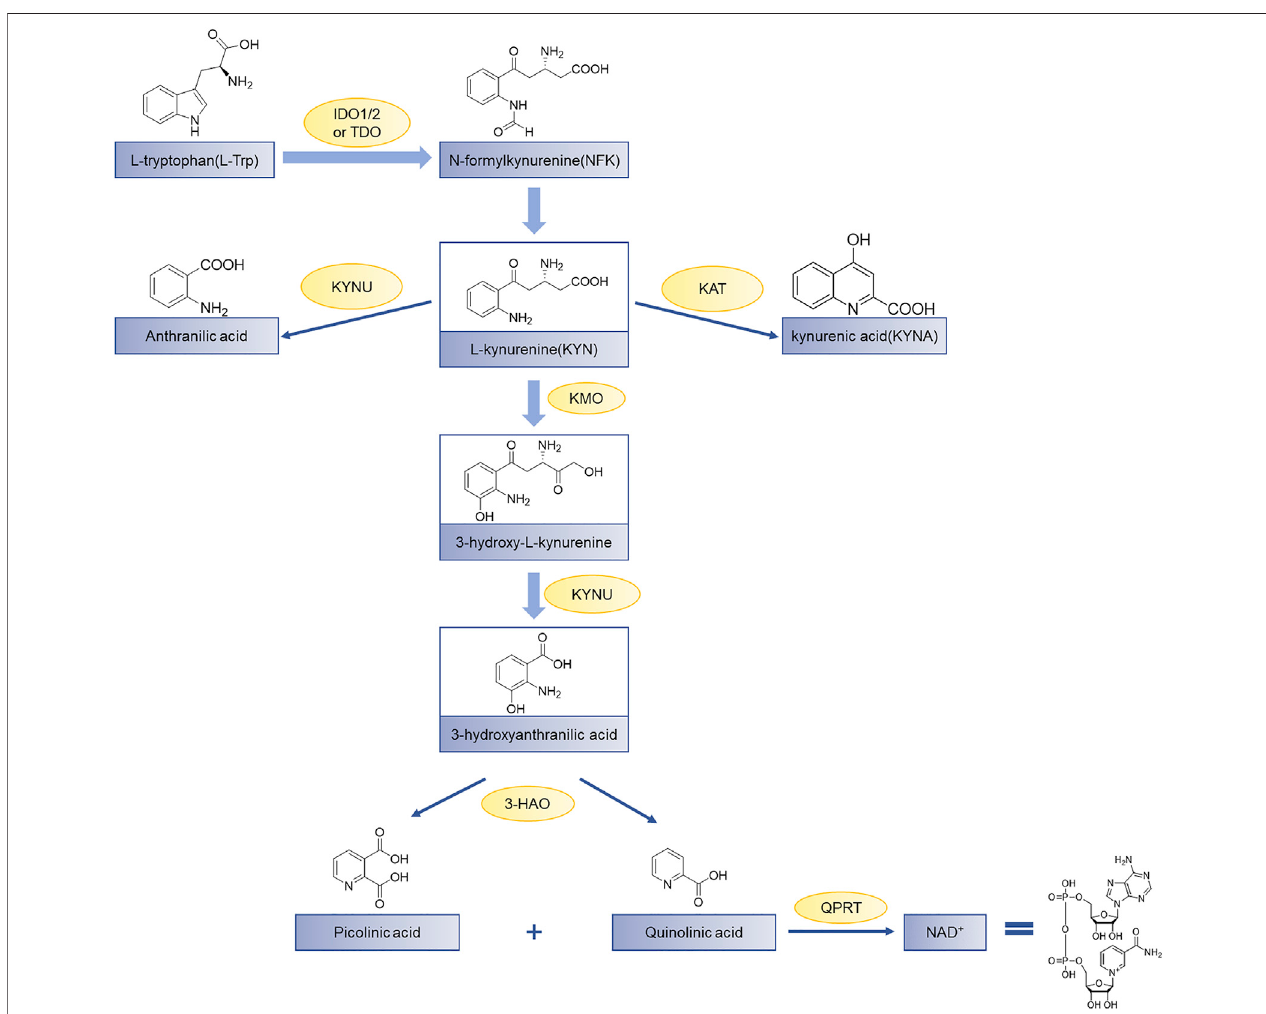
FIGURE1 | The kynurenine pathway oftryptophan metabolism. Tryptophan (Trp) is used for protein synthesis,while also participatesin themetabolismof aseries of important signaling molecules. The kynurenine pathway of Trp metabolism is catalyzed by three different enzymes to produce N-formylkynurenine, including indoleamine 2,3-dioxygenase 1 (IDO1), indoleamine-2,3-dioxygenase 2 (IDO2), and tryptophan 2,3-dioxygenase (TDO); KAT, kynurenine aminotransferase; KMO, kynurenine-3-monooxygenase; KYNU, kynureninase; 3-HAO, 3-hydroxyanthranilate 3,4-dioxygenase; QPRT, quinolinic-acid phosphoribosyl transferase (Zhai et al.,